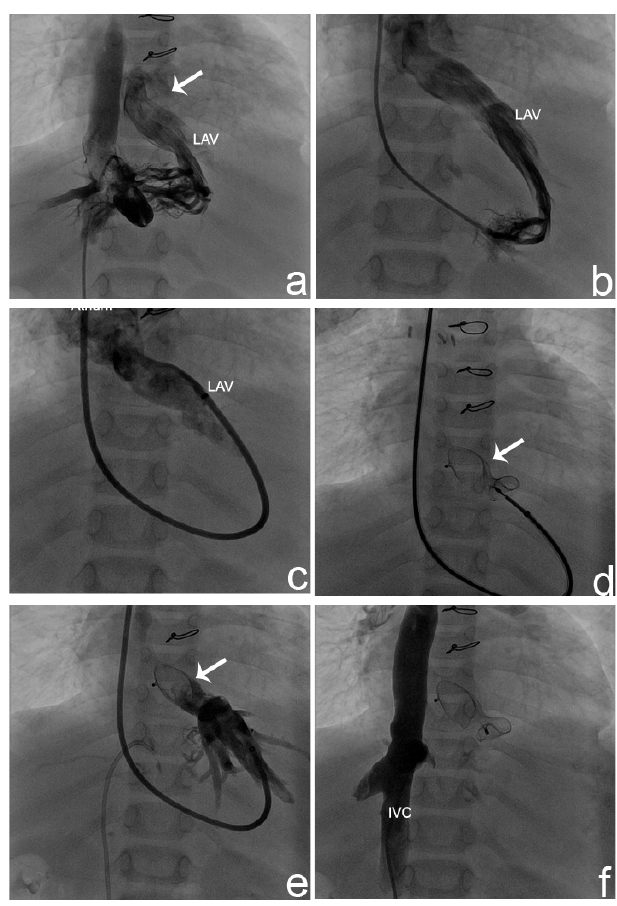
Fig. 3 - A: Angiogram of the left hepatic vein. B: Angiogram of the left accessory hepatic vein. C: 7F Cook Ansel guiding sheath advanced to the distal part of the left accessory hepatic vein. D: 16 mm ASO opened the atrium-hepatic vein junction. E: Angiogram of the left accessory hepatic vein after the device was released. F: No residual flow into the left hepatic vein and better flow to the pulmonary arteries. IVC= inferior vena cava; LAV= left accessory veins. Arrow shows atrium-hepatic vein